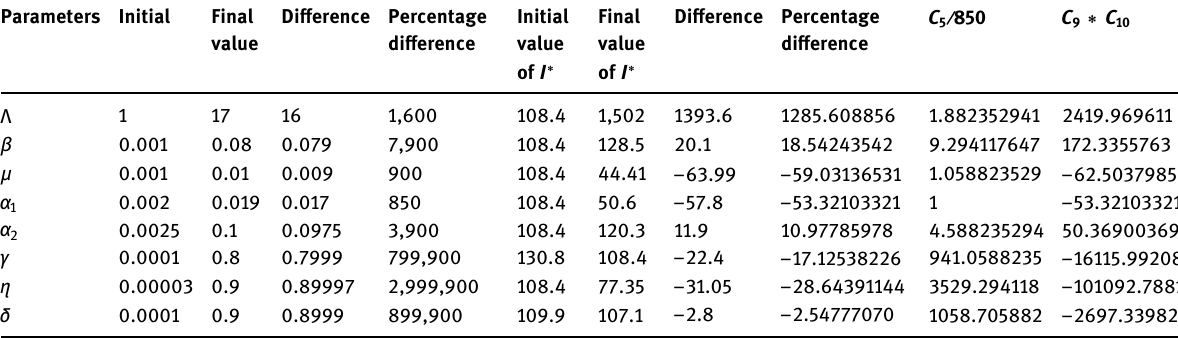
Table 2: Sensitivity of O ∗ for all model parameters Parameters